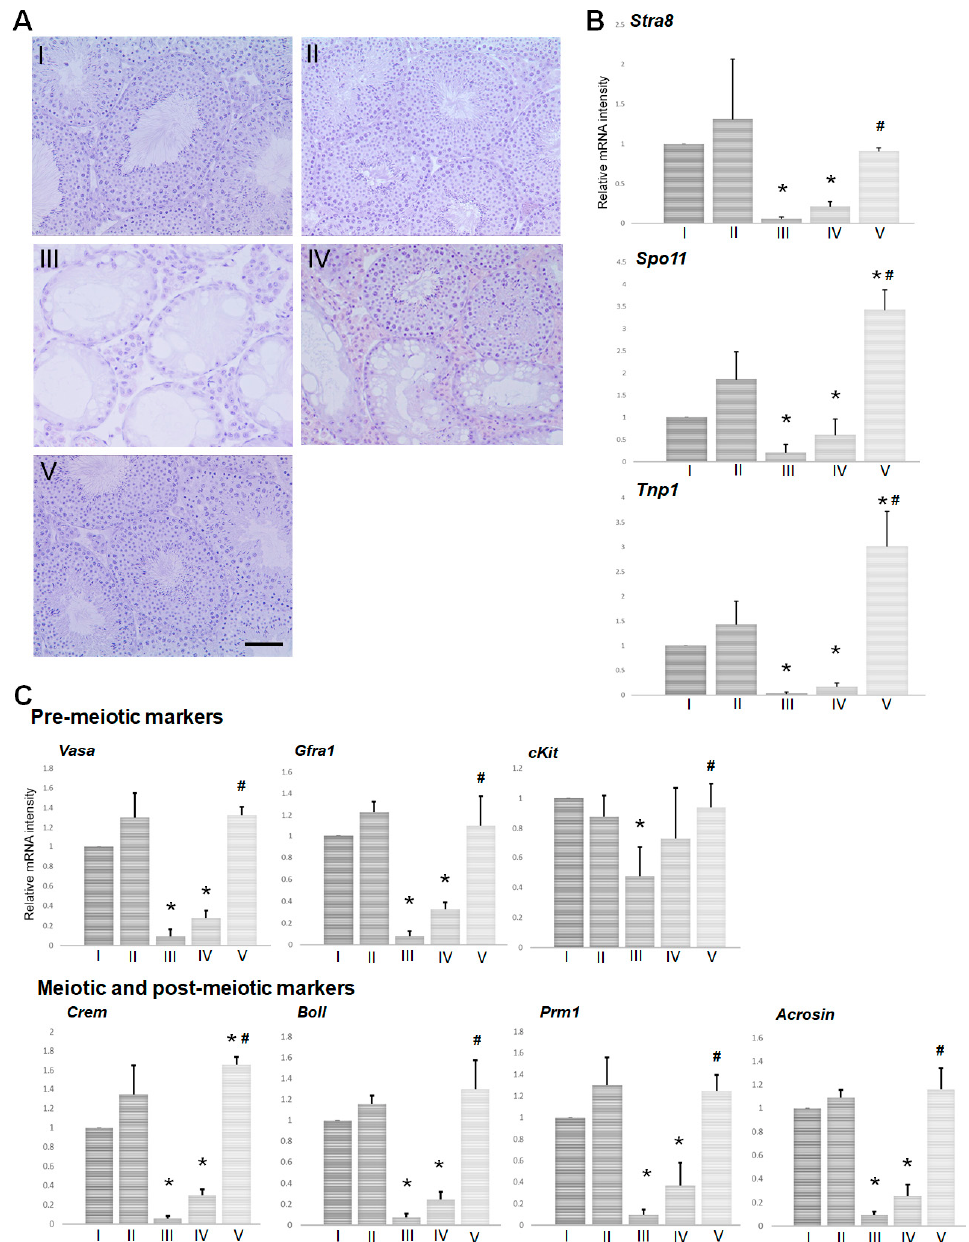
Figure 1. Testicular histology and the levels of three mRNA transcripts encoding markers of germ cell differentiation in each group at day 120 ( n = 5): ( A ) testes sections show morphology in groups I–V. Intact seminiferous tubules showing normal germinal epithelium from the spermatogonia to spermatozoa are observed in groups I and II. Atrophic seminiferous tubules with azoospermia are observed in group III. The presence of both atrophic and intact seminiferous tubules with spermatogenesis was observed in the group IV mice. Normal-appearing seminiferous tubules are observed in the group V mice (bar = 50 µ m). ( B ) Expression was measured by real-time RT PCR, and the results are expressed relative to the internal control GAPDH . Data show expression of the spermatogonial marker Stra8 , the spermatocyte marker Spo11 , and the spermatid marker Tnp1 . The results are expressed as the mean values ± standard deviation of five mice in each group, and the y-axis shows relative mRNA intensity. ( C ) Expression was measured by real-time RT PCR, and the results are expressed relative to the internal control GAPDH . Data show expression of the premeiotic markers ( cKit, Gfra1, and Vasa ), and the meiotic and postmeiotic markers ( Boll, Crem, Prm1, and Acrosin ). The results are expressed as the mean values ± standard deviation of five mice in each group, and the y-axis shows relative mRNA intensity. * p < 0.05 vs. group I; # p < 0.05 vs. group